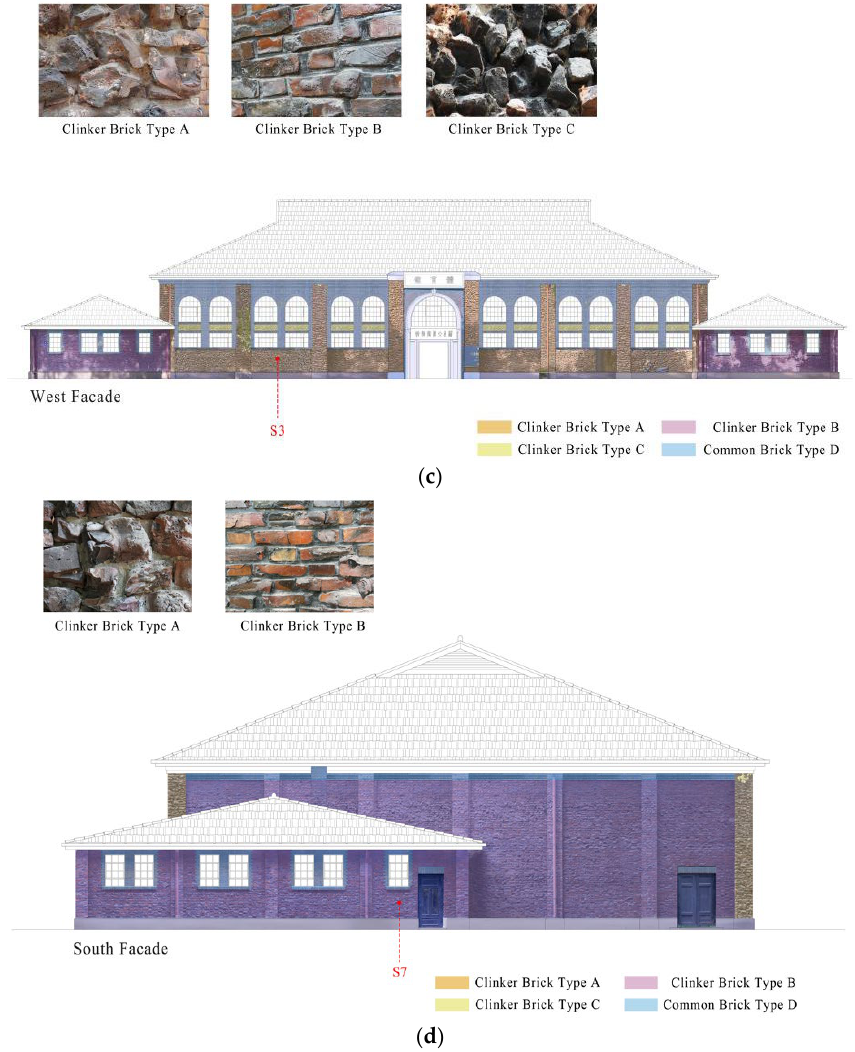
Figure 4. Morphological types of bricks and localization of the samples on the facades of the Smart Memorial Gymnasium. ( a ) North facade; ( b ) East facade; ( c ) West facade (main facade); ( d ) South facade. Table 1. Brick sample mark, location and macroscopic observation.